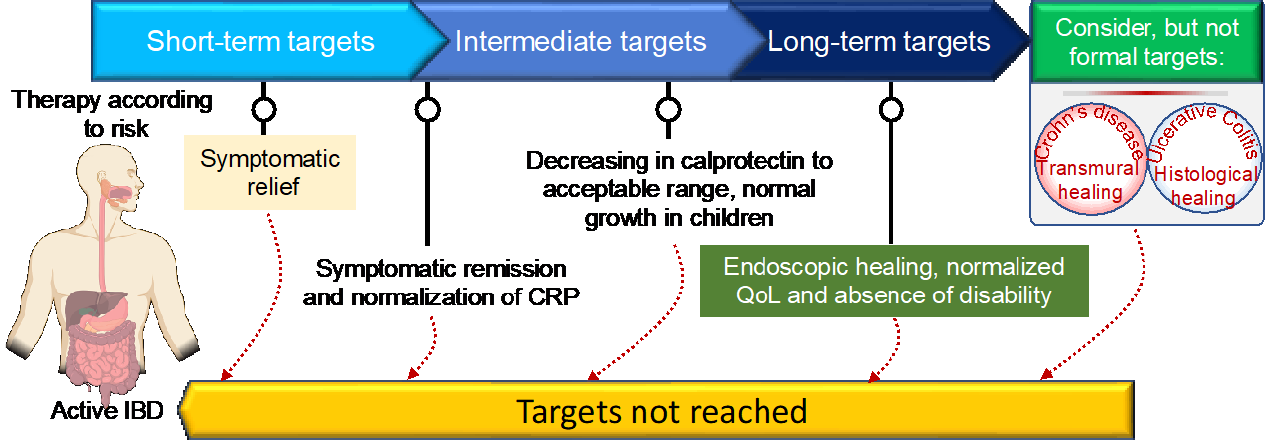
Figure 1. STRIDE-II recommendations for disease monitoring and clinical management of inflamma- tory bowel disease using short- and long-term target